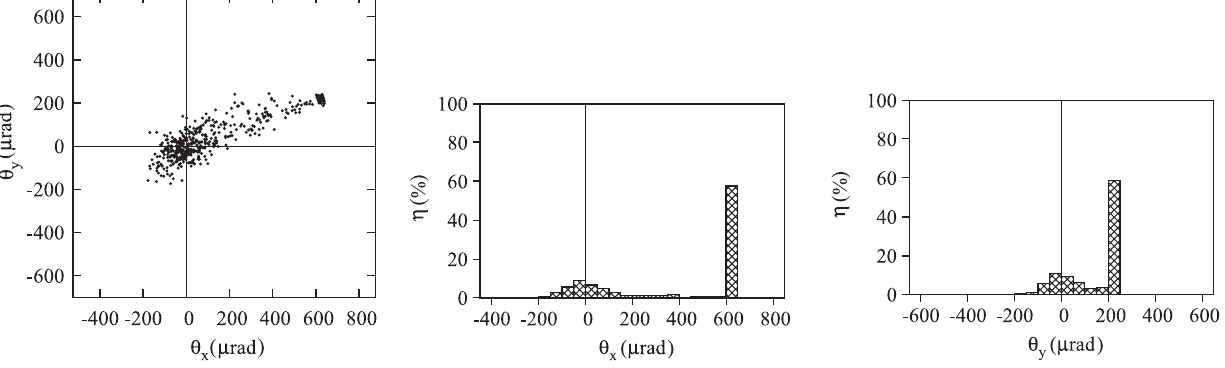
regime.FIG. FIG. 15. The same as in Fig. 12 for the conditions of 50 GeV particles motion in the stochastic deflection FIG. 16. The same as in Fig. 15 for protons with kinetic energy of 1